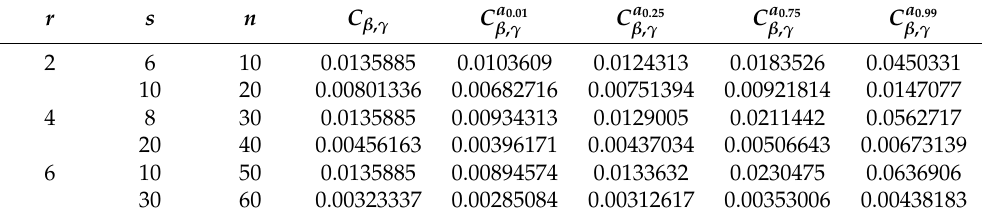
Table 1. Unconditional and conditional lower ( β , γ ) tolerance factors, C β , γ and C a ε model based on X = ( X r : n ,..., X s : n ) when α = 1, β = 0.90, and γ = 0.95. r s n C β ,